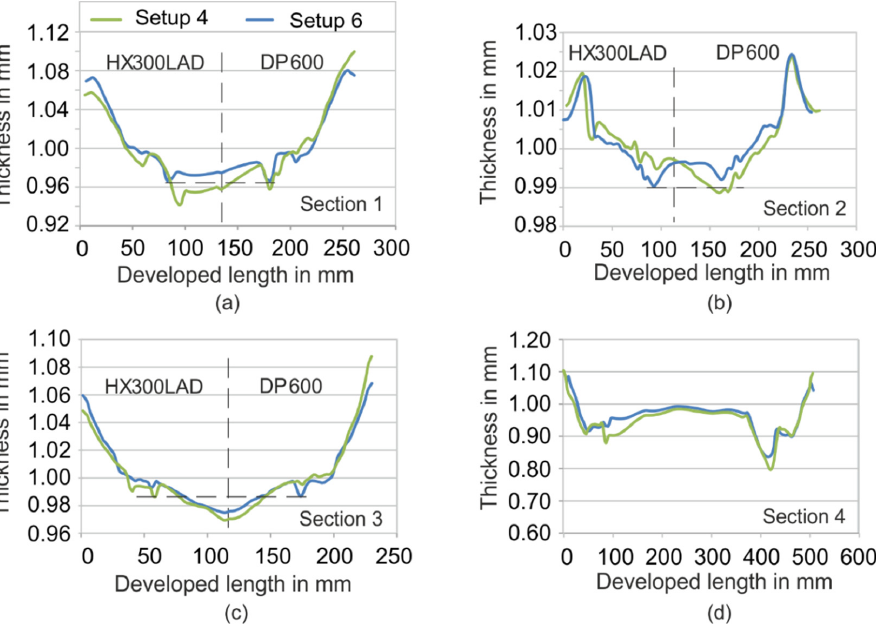
Figure 12. Thickness distribution for setups 4 (steel/polymer K3) and 6 (steel/multi ‐ spring). ( a ) Section 1; ( b ) Section 2; ( c ) Section 3; ( d ) Section 4.